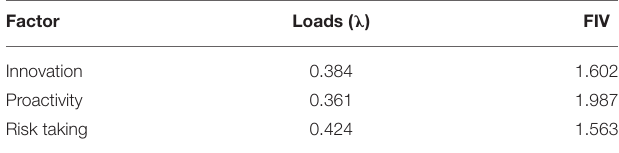
TABLE 9 | Collinearity of entrepreneurial